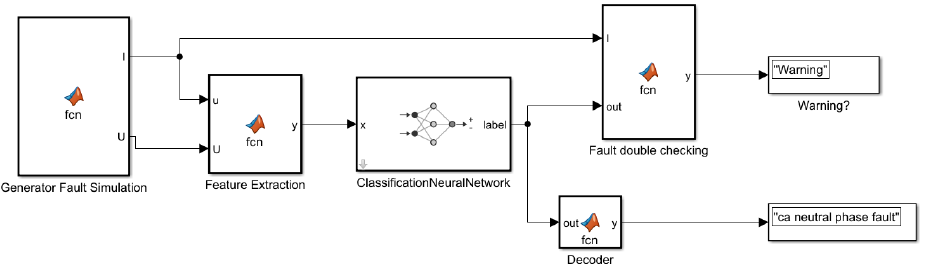
Figure 22. Block diagram of the decision-making system about the operation of the generator in the case of an asymmetric